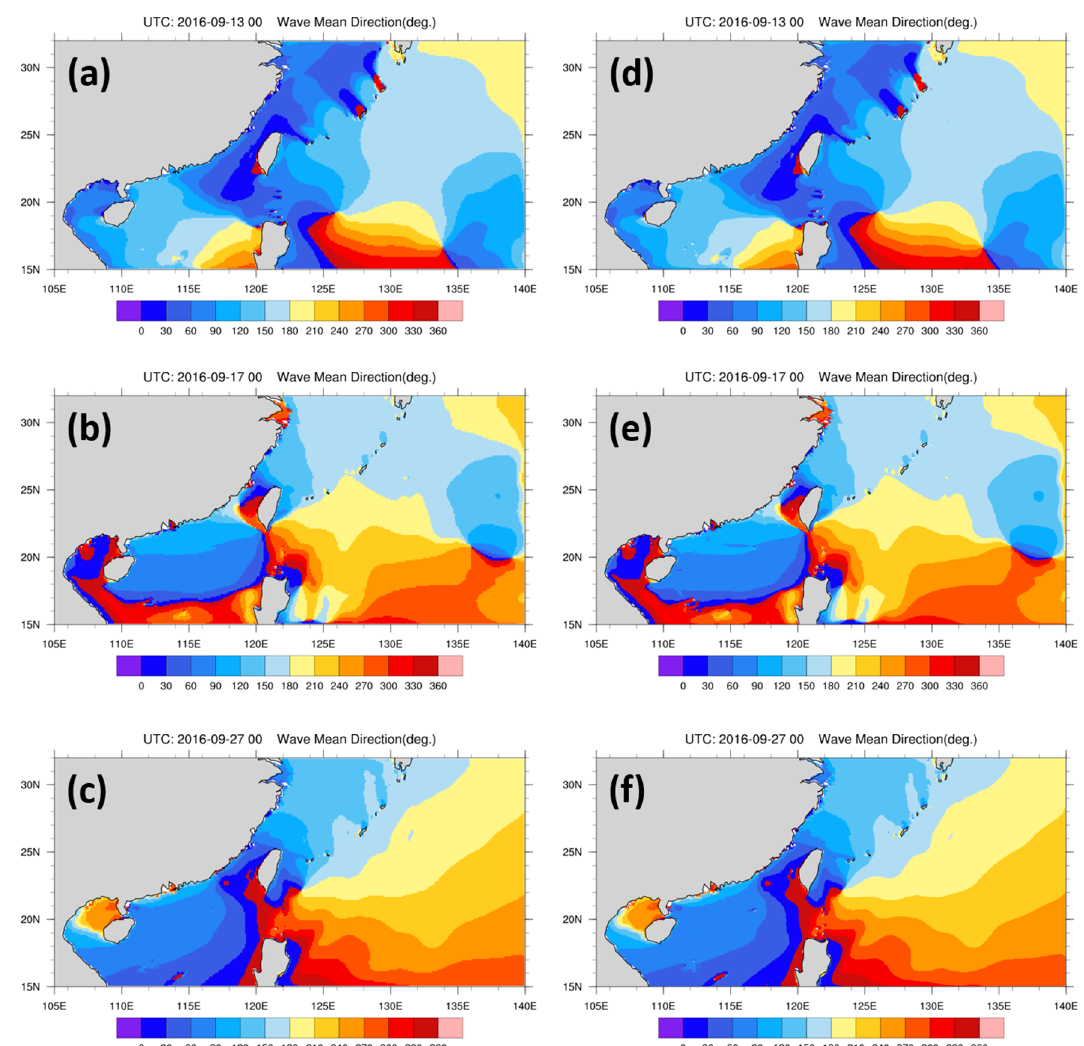
Figure 16. Spatial distribution of wave direction driven by the CFSv2 using the WW3 model with 0.1 deg ( a – c ) and 0.05 deg grid resolutions for Typhoons Meranti ( a , d ), Malakas ( b , e ), and Megi ( c , f ).